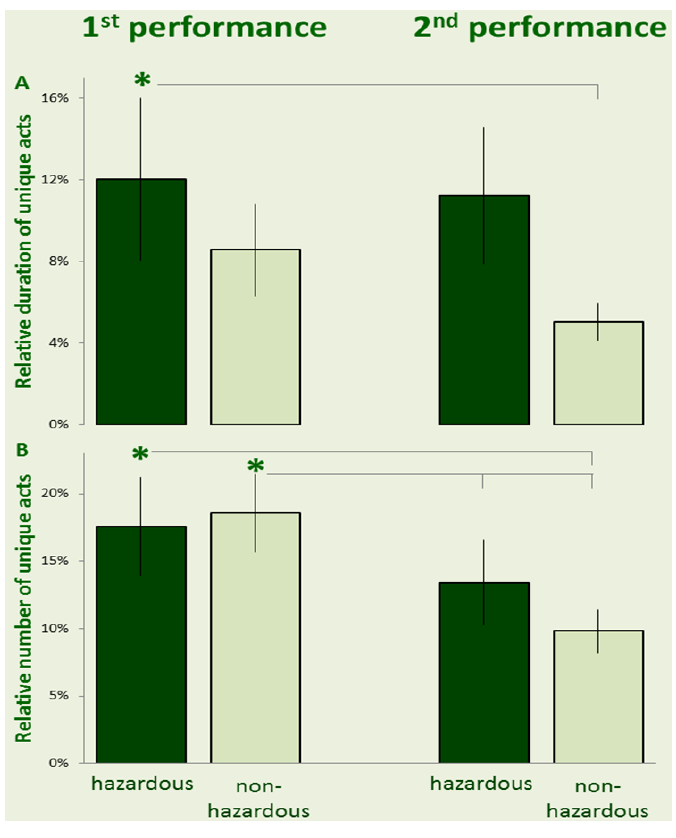
Figure 3. The mean (± SE) relative duration of idiosyncratic acts ( A ), and the relative number of idiosyncratic acts ( B ) are depicted for hazardous (dark bars) and non-hazardous trials (light bars) during the first performance (left-hand insets) and second performance (right-hand insets). (* indicates a difference between the trials, connected by the horizontal